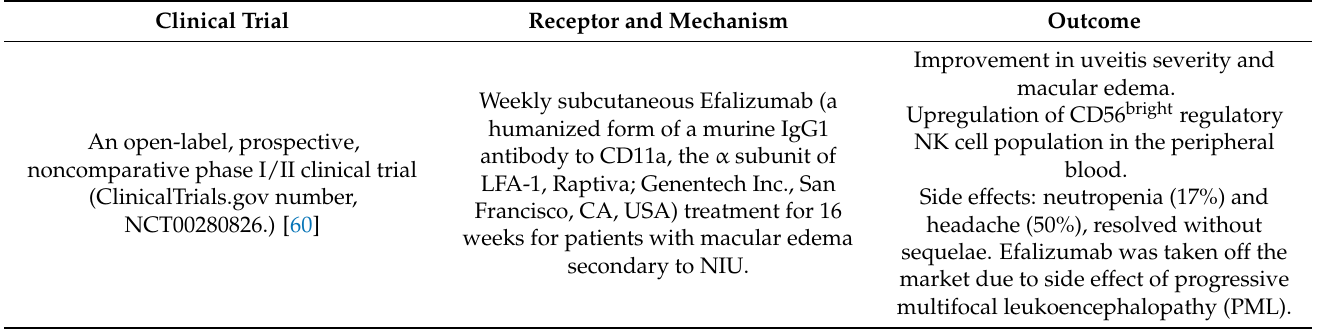
Table 2. Integrin based therapy for non-infectious uveitis